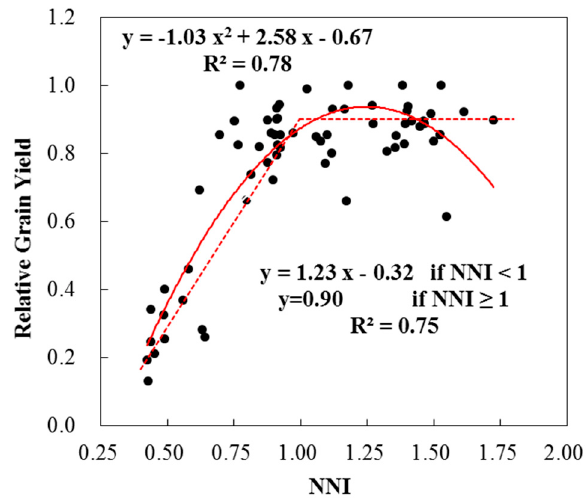
Figure 2. Relationships between the relative grain yield and the NNI of winter wheat. 5